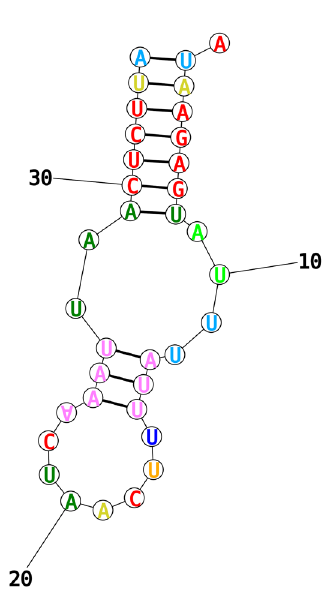
Figure 2. Predicted truncated tRNA structure. RNA structure for the truncated tRNA between ND4 and COX1, predicted by RNAstructure